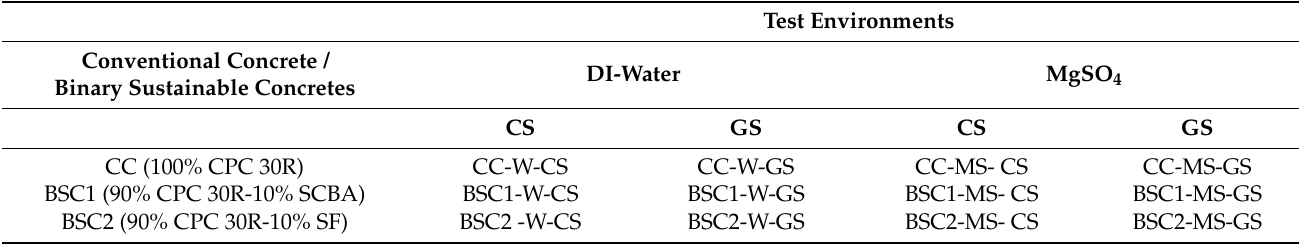
Table 5. Nomenclature of specimens for evaluation of corrosion.